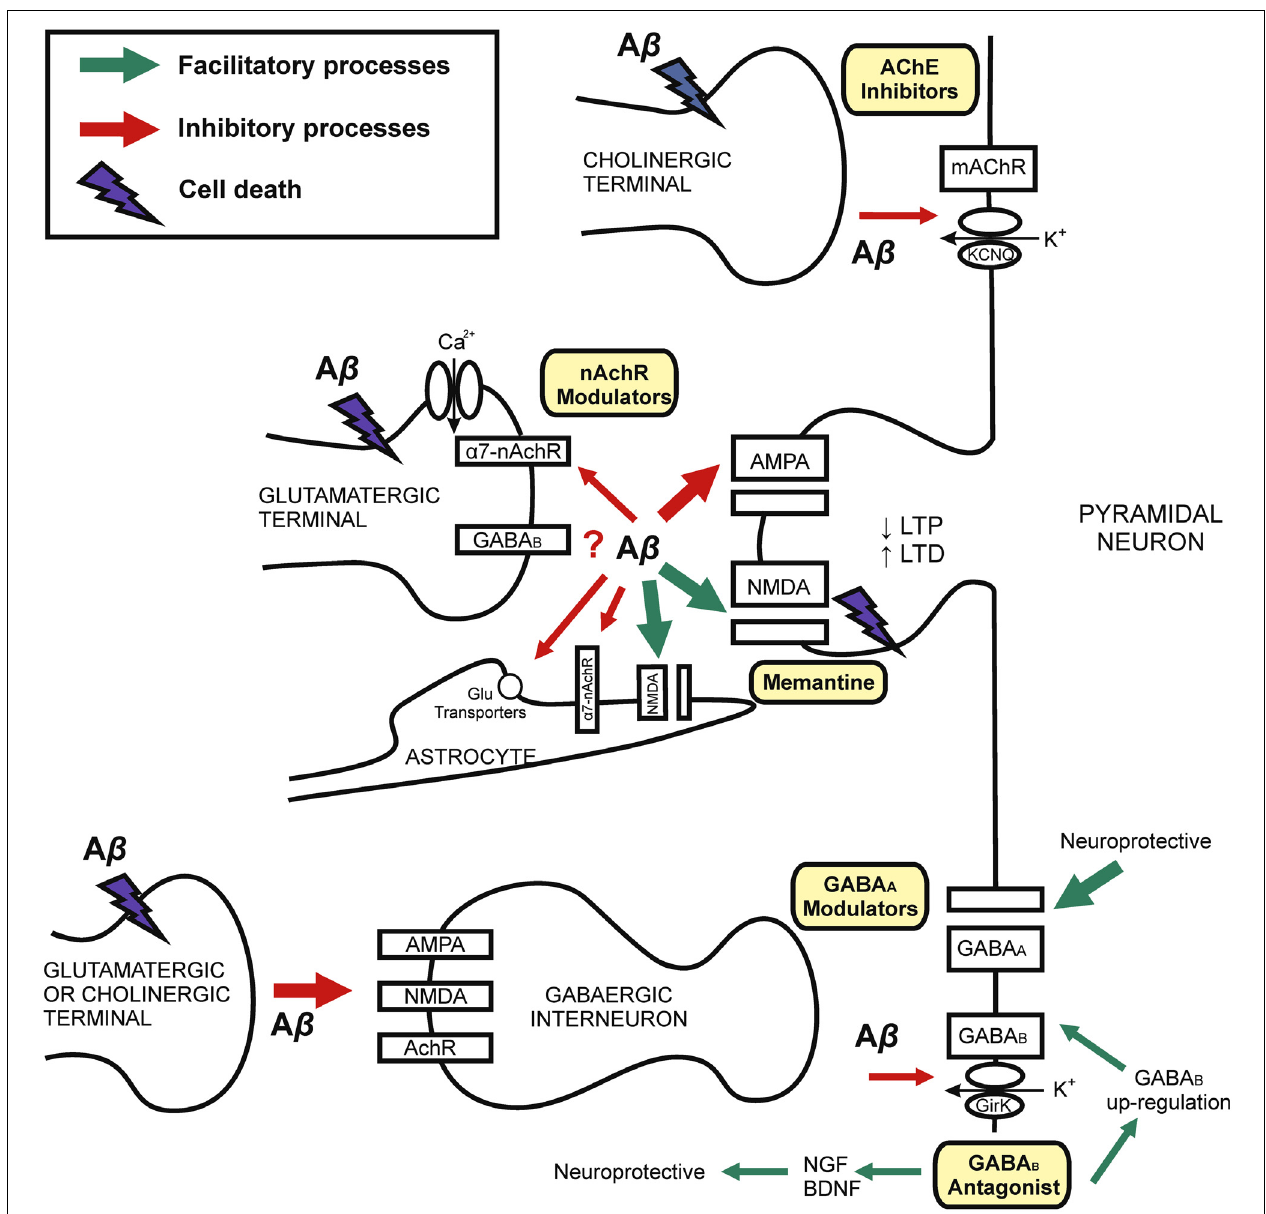
FIGURE 1 | Mechanisms of synaptic dysfunction inAlzheimer’s disease. Schematic drawing showing the role of A β in the physiopathology of AD and different targets for pharmacological modulation. AD is explained by A β -induced neurodegeneration, therefore with decline in synaptic terminals (left) on both principal cells and inhibitory interneurons. Chronic exposition to A β induces neuronal death. Synaptic loss is related with cognitive impairment in AD. Early memory decline is correlated with A β -synaptic dysfunction on excitatory and inhibitory receptors and neurotransmission. Current evidence for the treatment of AD involve both glutamatergic (NMDA-type glutamate receptors antagonist, i.e., memantine ) and cholinergic (i.e., cholinesterase inhibitors , AChE inhibitors) transmission.The GABAergic system is a possible target for developing pharmacological interventions. GABA B receptors may